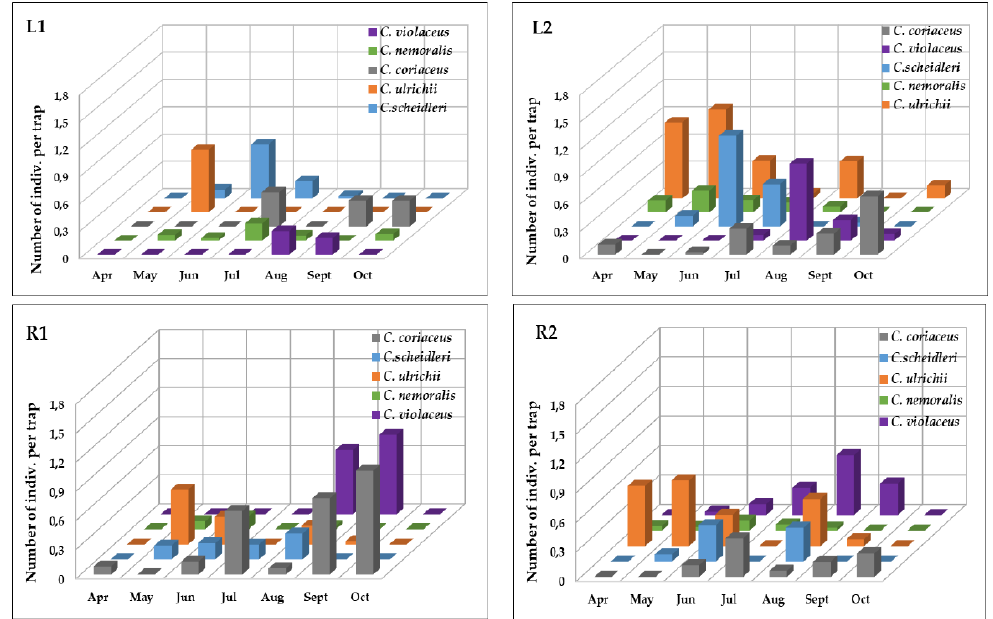
Figure 3. The monthly activity of five carabid species at B á b forest stands with four di ff erent study plots in 2017. Two forest stands: L1—close-to-nature forest plot; L2—managed forest plot. Two stands after logging operations 10 years ago: R1—recovering indigenous tree species plot; R2—alien Ailanthus altissima dominance.